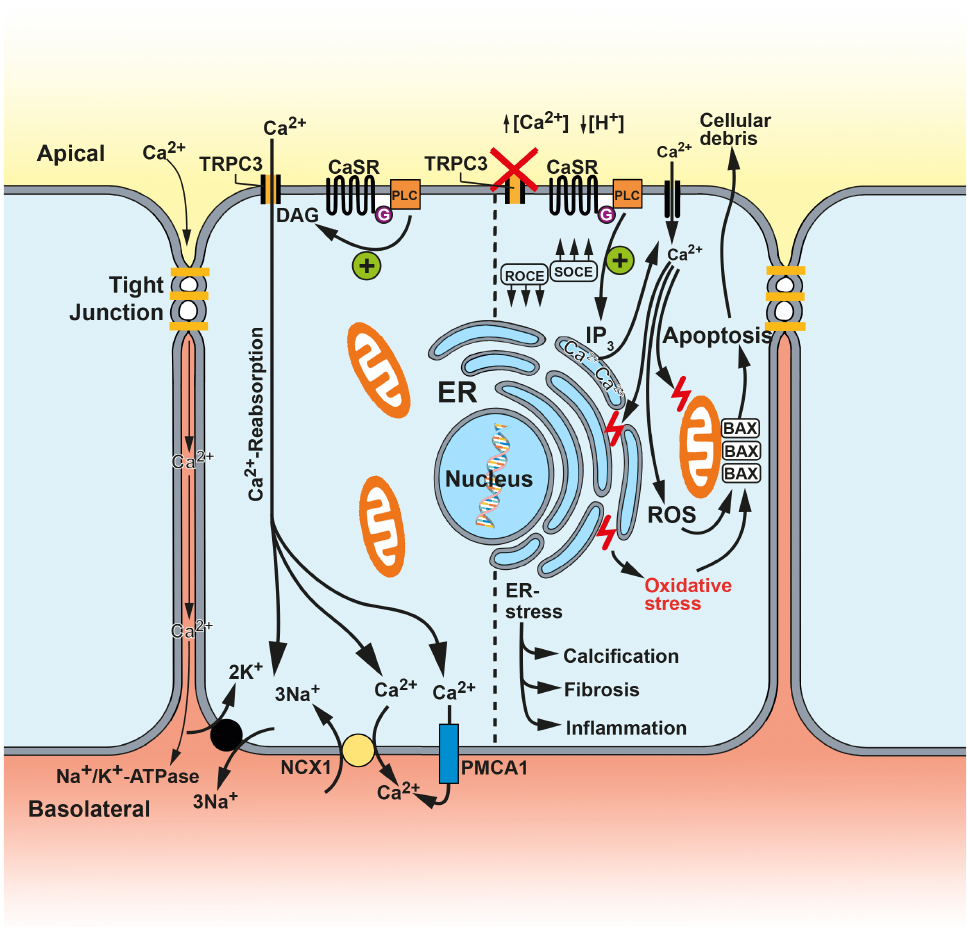
Figure 3. The suggested role of TRPC3 in the proximal tubule cell. The cell is divided in two halves. The left half shows the proposed physiological function of TRPC3 in the proximal tubule. Luminal Ca 2+ activates the calcium sensing receptor (CaSR), which triggers in turn the G-protein associated phospholipase C pathway. DAG is generated and increases TRPC3 activity. Receptor-operated Ca 2+ entry (ROCE) results. Basolateral players including the plasma membrane Ca 2+ -ATPase 1 (PMCA1) and the Na + /Ca 2+ -exchanger 1 (NCX1) mediate the basal Ca 2+ export. The right half shows a TRPC3-deficient proximal tubule cell which is exposed to alkaline hypercalciuric conditions. SOCE pathways outweigh ROCE pathways. Then, ER stress and ROS generation follow, along with subsequent calcification, inflammation, fibrosis, and apoptosis. Cellular debris accrue and promote stone formation which in turn aggravates the tubular damage. TRPC3 is suggested to contribute to prevention of such exacerbated luminal Ca 2+ concentration and subsequently to attenuation